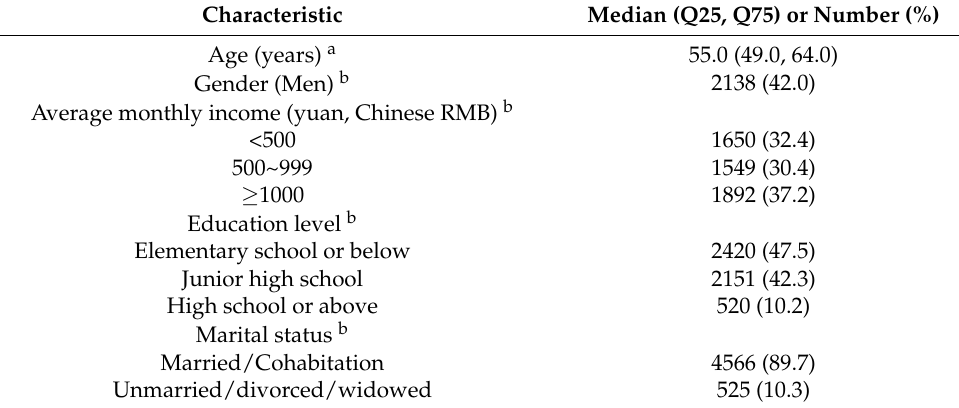
Table 1. Demographic characteristics of all participants.